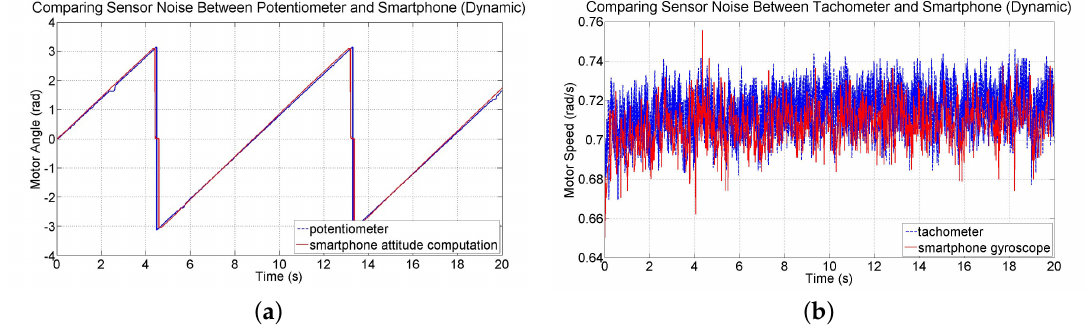
Figure 11. Comparisons between ( a ) smartphone attitude sensing and potentiometer readings and ( b ) smartphone gyroscope readings and tachometer readings while the motor is driven at constant